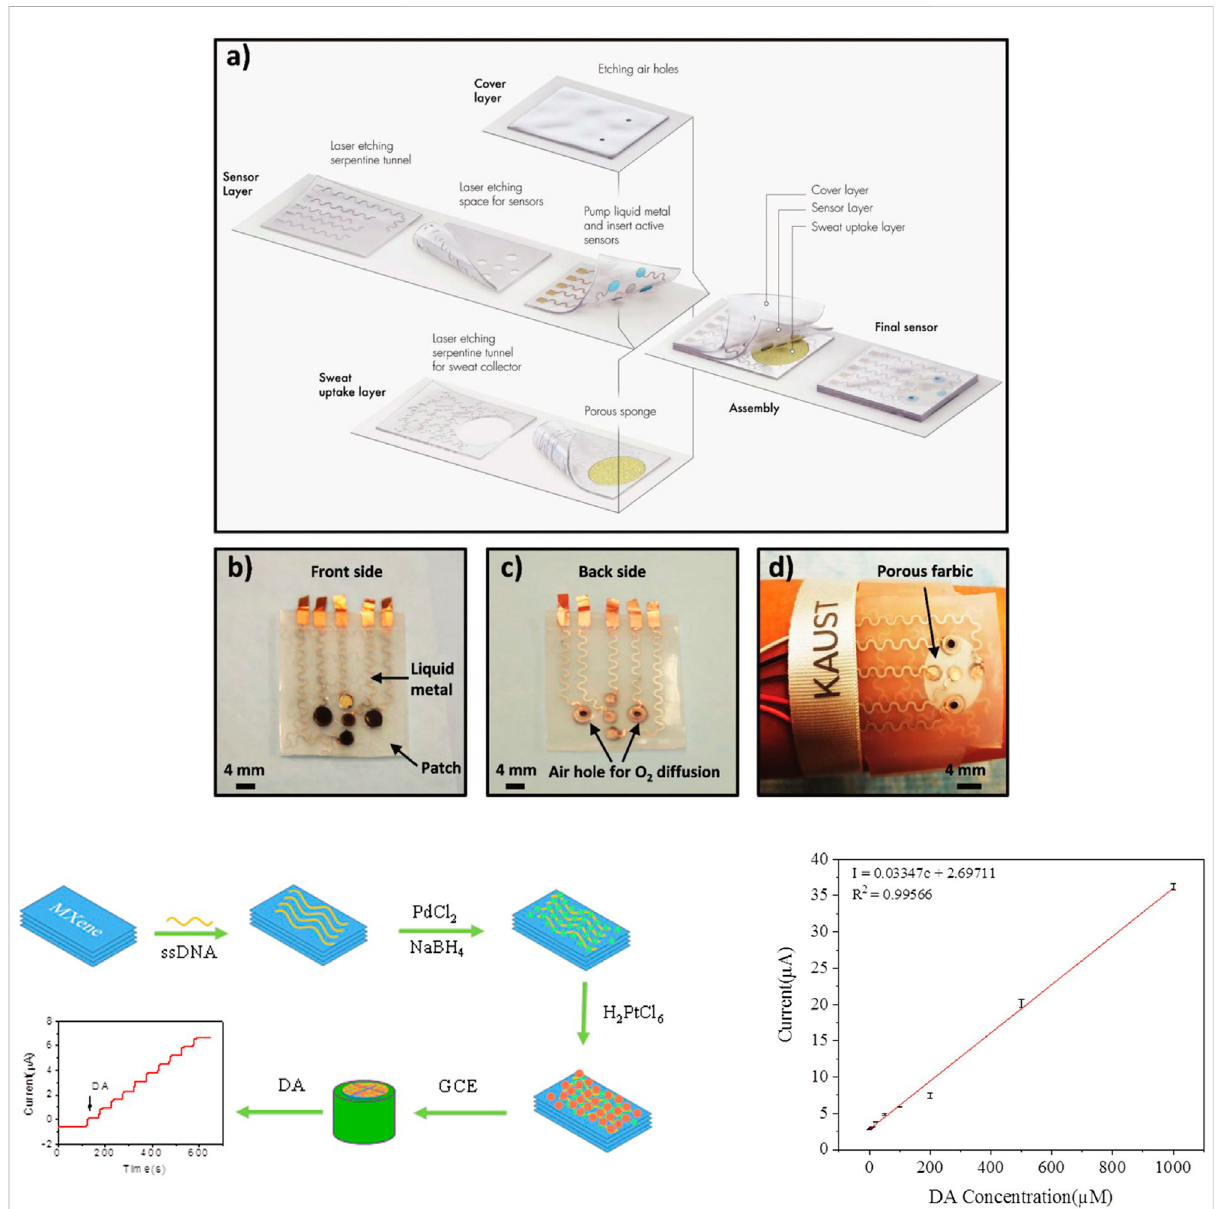
FIGURE 10 (A) Schematic illustration of the stretchable and wearable biosensor based on MXene/Prussian blue (Ti3C2/PB) composite, which is composed of a sweat-uptake layer, a sensor layer, and a cover layer. The optical images show the front-side and back-side of the sensor, as well as the sensor wristbandlaminatedonhumanskin,ReproducedwithpermissionfromLeietal.(2019),©Wiley-VCH. (B) Theschematicdiagramofthefabricationof Ti 3 C 2 /DNA/Pd/Pt nanocomposite, and the linear calibration curve of the response current vs DA concentration for Ti 3 C 2 /DNA/Pd/Pt/GCE in stirred 0.1 M pH 7.0 PBS containing 0.2 – 5,000 μ M DA. The error bars are standard deviations of three measurements, Reproduced with permission from Zheng et al. (2018a),